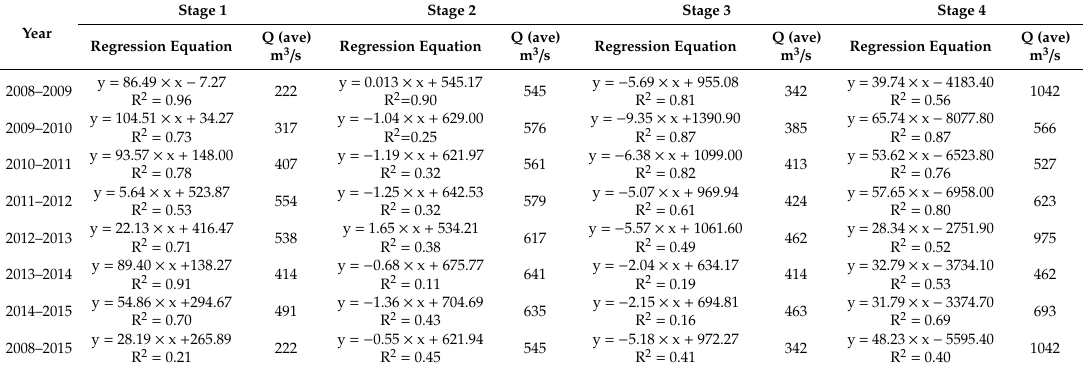
Table 2. Linear regression results of the discharging processes during the ice jam flooding seasons.